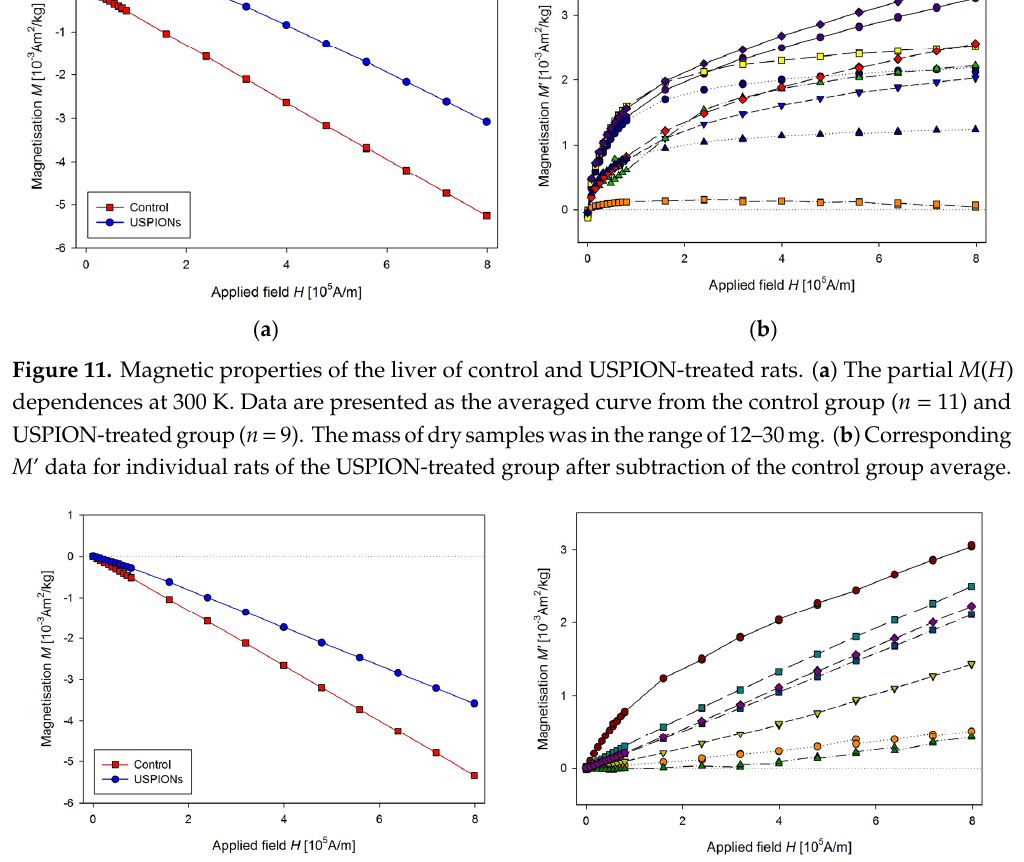
Figure 12. Magnetic properties of the left heart ventricle of control and USPION-treated rats. ( a ) The partial M ( H ) dependences at 300 K and ( b ) corresponding M ’ data for individual rats of the USPION-treated group after subtraction of the control group average. Data (a) are presented as the averaged curve from the control group ( n = 10) and USPION-treated group ( n = 7). The mass of dry samples was in the range of 14–25 mg.